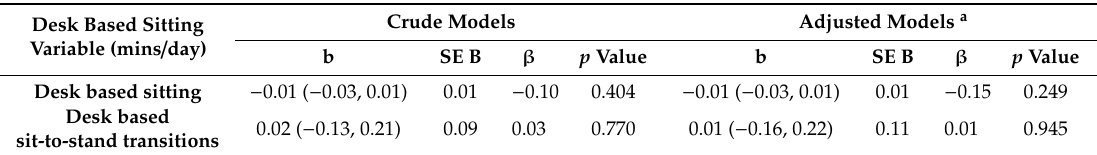
Table 3. Associations between desk-based sitting, desk-based sit-to-stand transitions and perceived stress levels (from those who also had hair